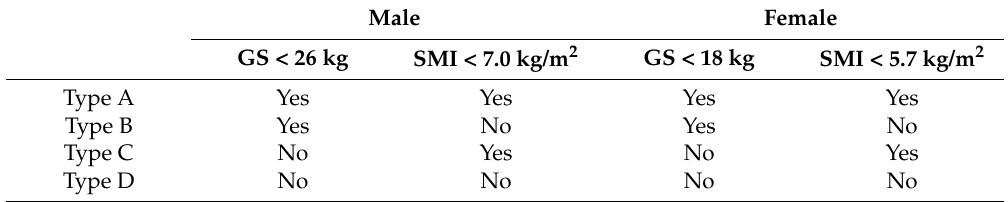
Table 1. Our type classification stratified by grip strength (GS) and skeletal muscle mass index (SMI).